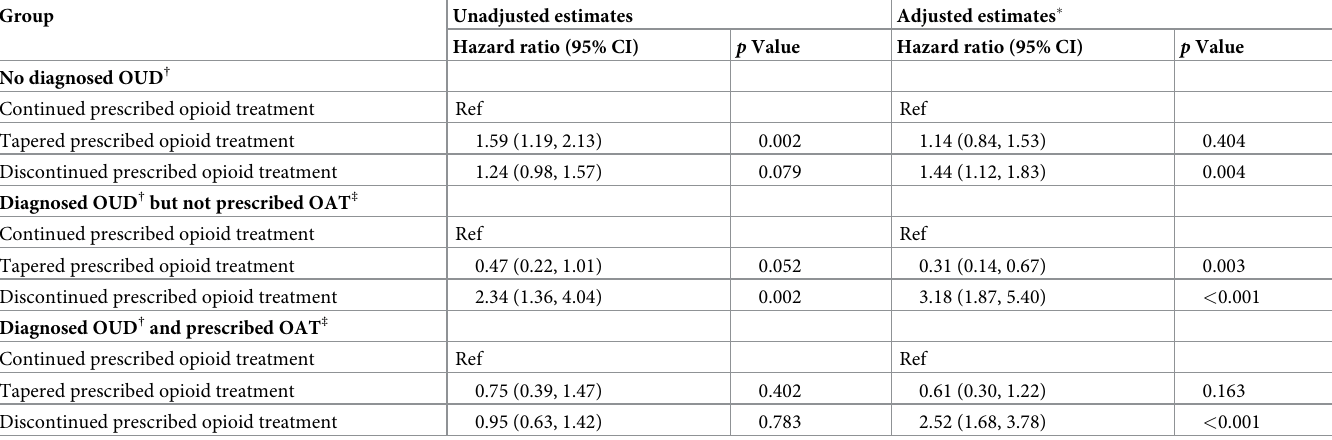
Table 2. Regression analyses of the effects of discontinuation and tapering of prescribed opioid treatment for pain on risk of overdose among people on long-term opioid therapy for pain in British Columbia, Canada, stratified by diagnosed OUD and prescribed OAT